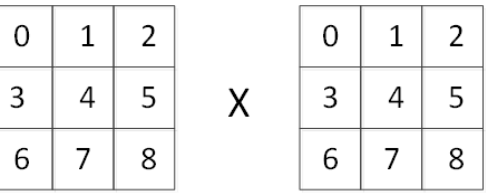
Figure 9. Example of image patch and convolution kernel. The number in each box is the index of corresponding pixel or the convolution kernel’s